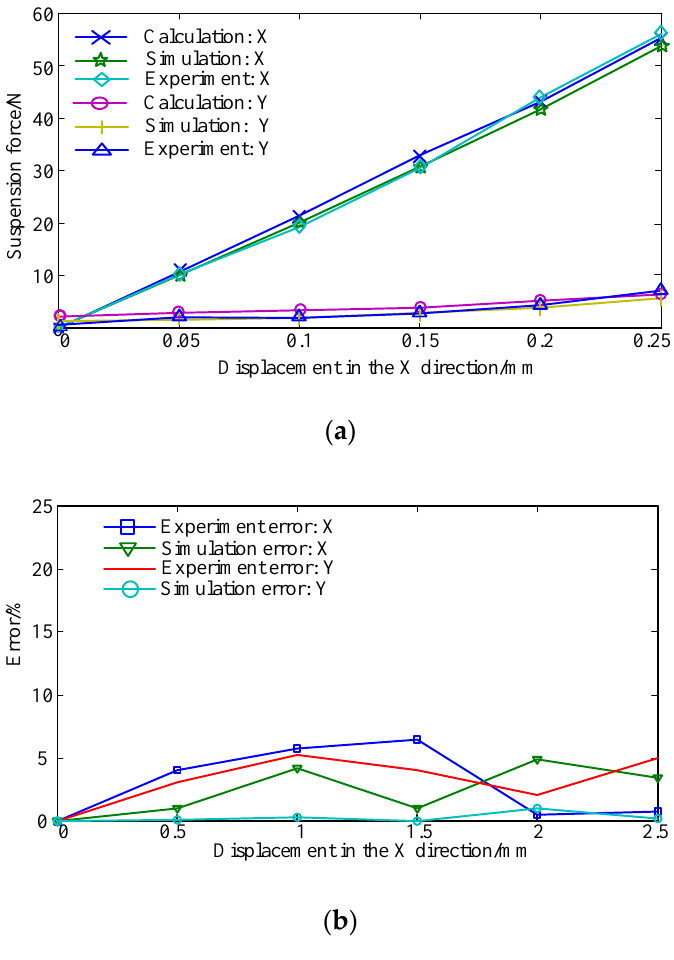
Figure 11. ( a ) Suspension force related to eccentricity along the X-axis ( b ) Error comparison between experiment and simulation